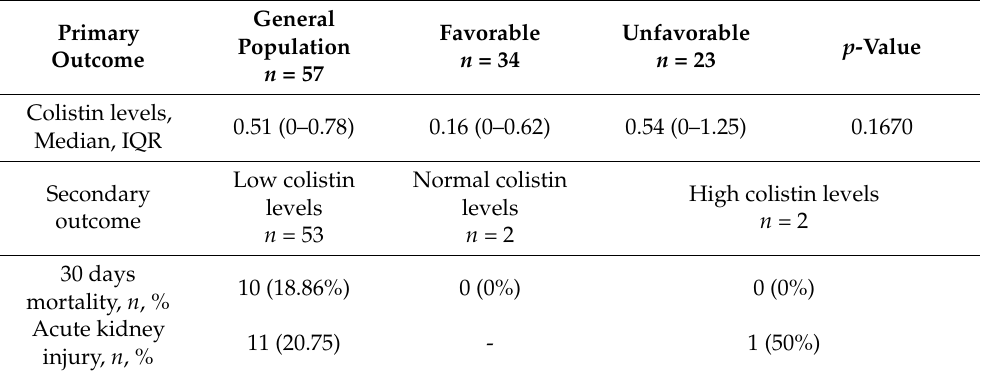
Table 5. Primary and secondary clinical